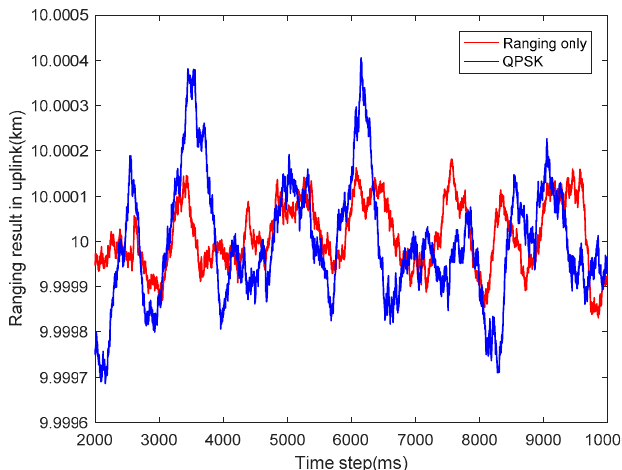
Figure 6. Ranging result in uplink with the ranging branch only and QPSK modulation with (𝐶/𝑁 ) = 45 dB·Hz. ( C / N ) = 45 dB · (cid:2868) (cid:3048)(cid:3043)(cid:3039)(cid:3036)(cid:3041)(cid:3038) 0 uplink